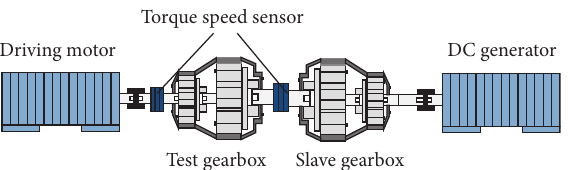
Figure 9: Test setup of the 2-stage planetary gearbox.